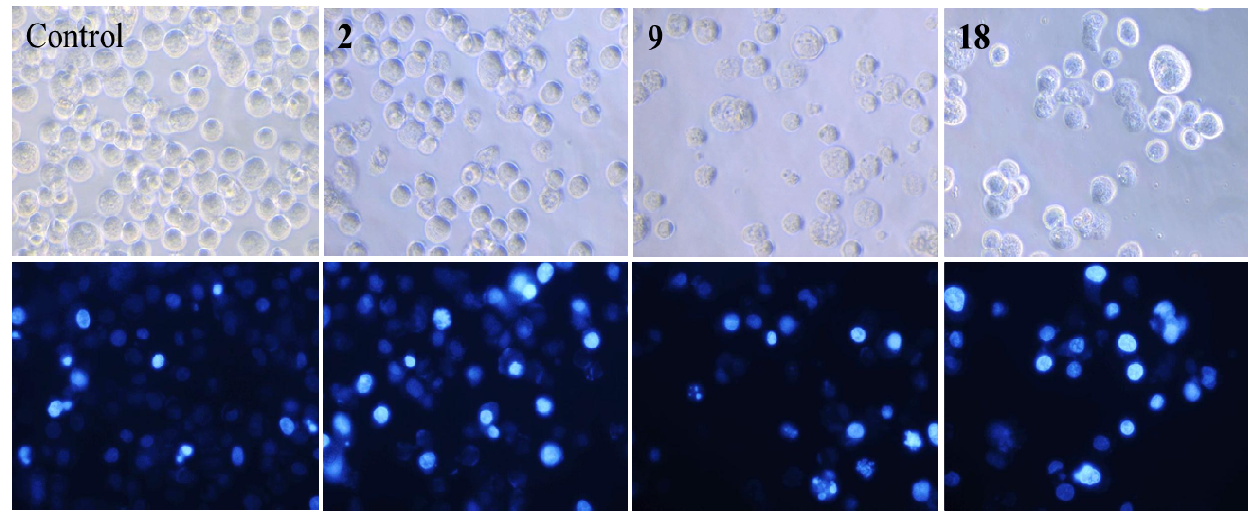
Figure 2. (Top) Cell morphological observations of nuclear change of human hepatoma HepG2 cell lines after 48 h exposure (untreated), with 40 μ M norcantharidin ( 2 ), compounds 9 and 18 . (Bottom) Cells were stained with Hoechst 33258 and examined using a Nikon (Tokyo, Japan) fluorescence microscope. (Magnification,